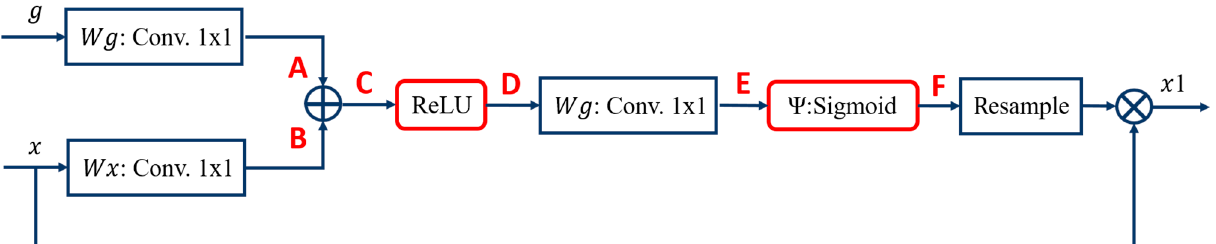
Figure 5. Details of AGs module.